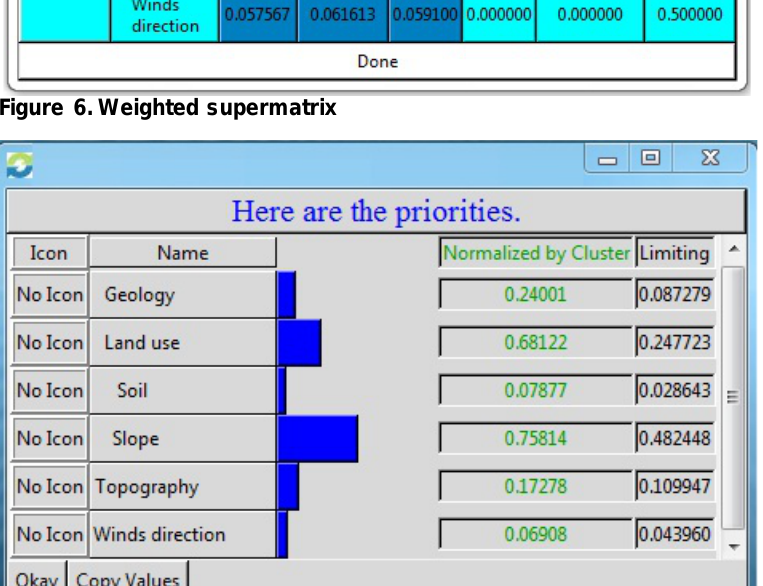
Figure 7. Priority of criteria